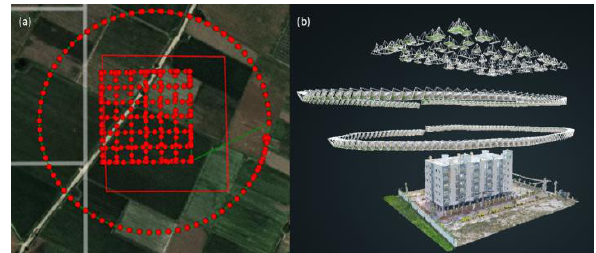
Figure 5: Data collection by using two flight plans (a) Double grid mission/linear mission (b) Circular mission